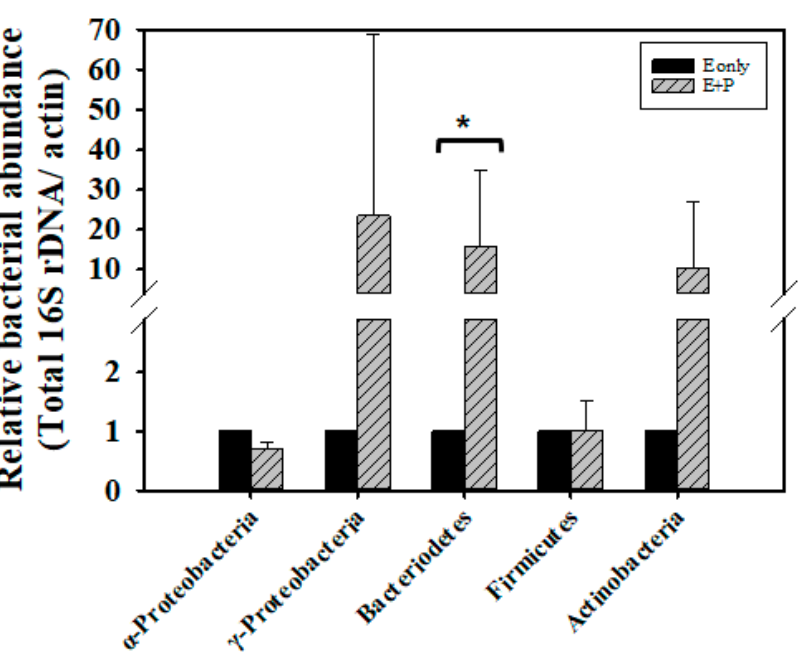
Figure 4. Bacterial abundance in the guts of honey bees fed with EPS and bee pollen. The bacterial loads of α -Proteobacillus, γ -Proteobacillus, Bacteriodetes, Firmicutes and Actinobacteria in the guts of bees were assessed through quantitative polymerase chain reaction (qPCR). DNA samples obtained from the guts of 7-day-old workers fed with 50% sucrose syrup containing 1% EPS (E only) or 50% sucrose syrup containing 1% EPS and bee pollen (E + P), were prepared for qPCR. The relative bacterial abundance was analyzed using the 2 − ∆∆ CT method. Data represent the mean of four repeats (10 guts for each repeat), with error bars indicating the standard deviation. Bar with the label * is significantly different ( p < 0.05) accordingly to the Mann-Whitney U test.